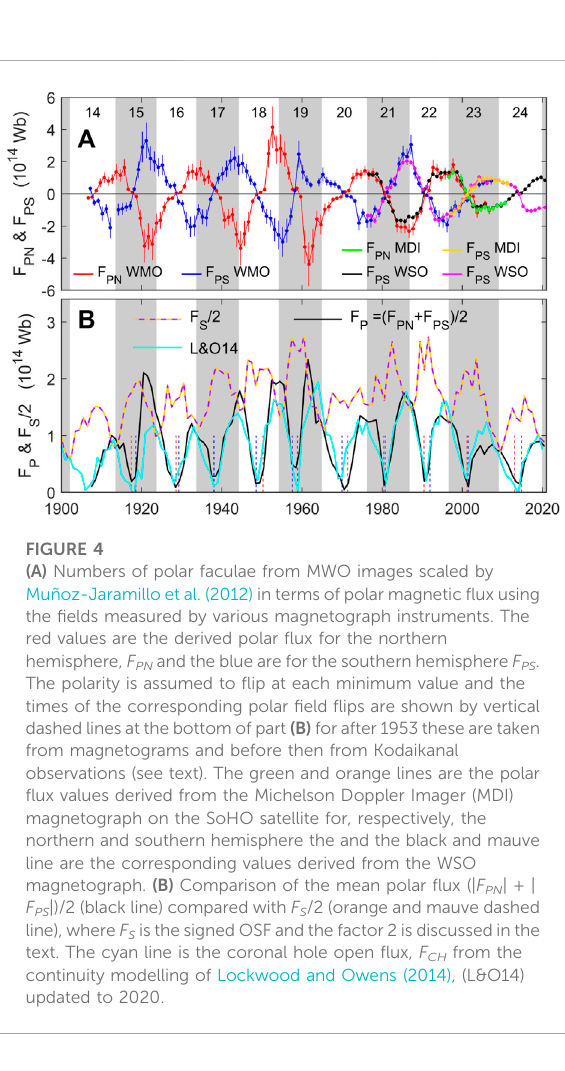
times of polar fi eld polarity reversals (in red and blue for northern